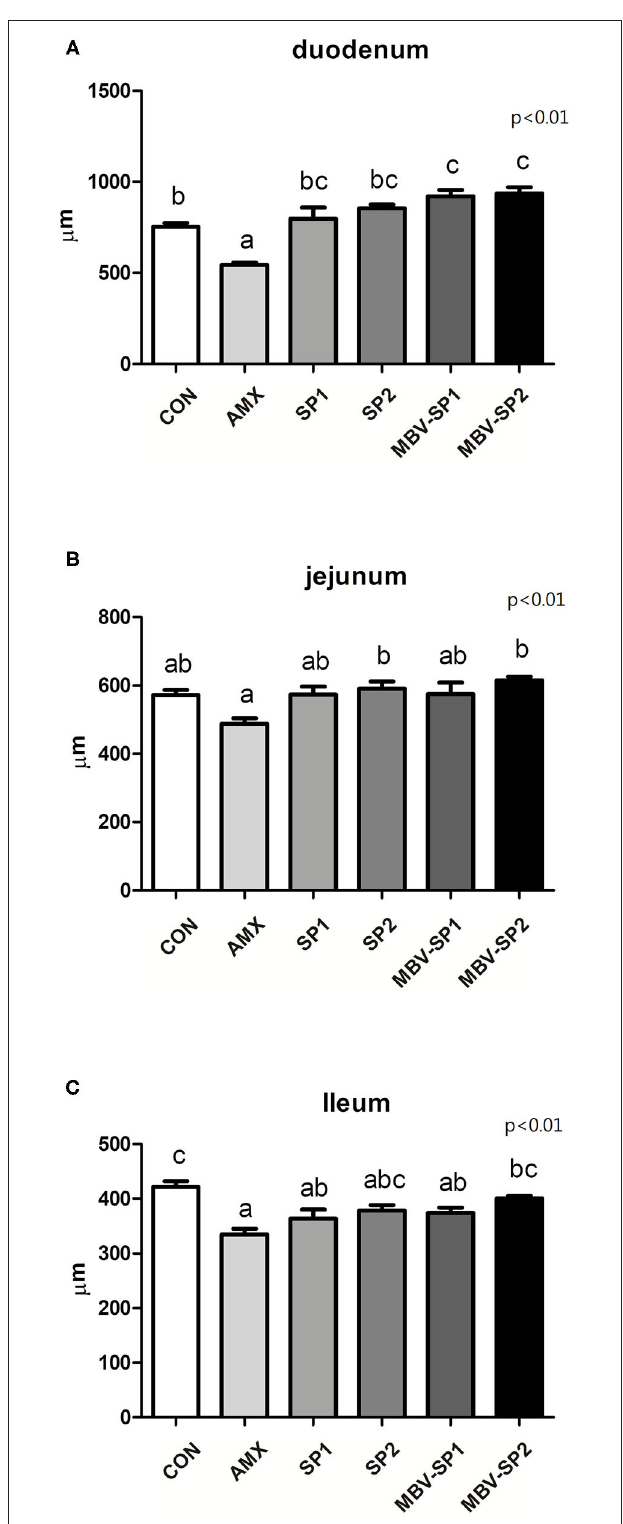
FIGURE 1 | Histological analysis of broiler small intestine after feeding with basal diet (CON), AMX, SP1, SP2, MBV-SP1, and MBV-SP2 of (A)